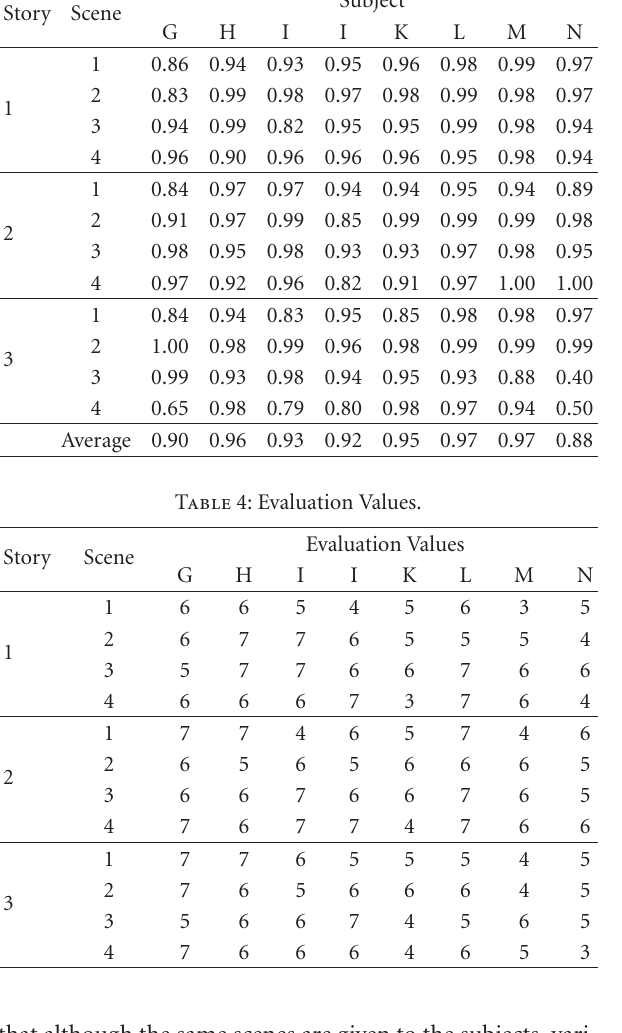
Table 3: Cosine Similarity. Story Scene